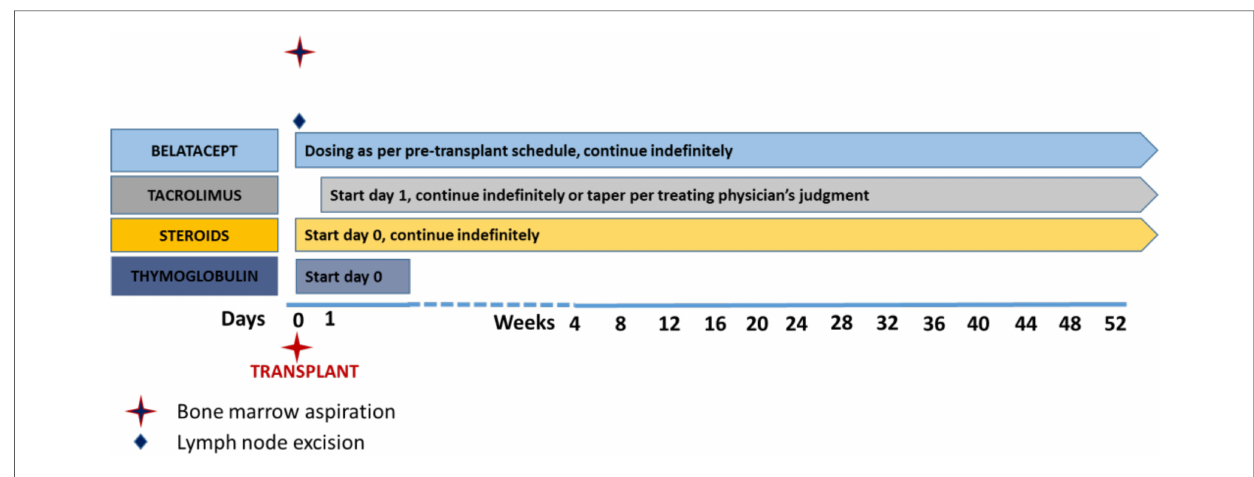
FIGURE 2 Post-transplant immunosuppression regimen. Patients in the ADAPT trial who receive transplants are induced with thymoglobulin and maintained on maintenance immunosuppression including belatacept, tacrolimus (weaned according to physician preference), and steroids. Other drugs such as MMF are per physician preference.